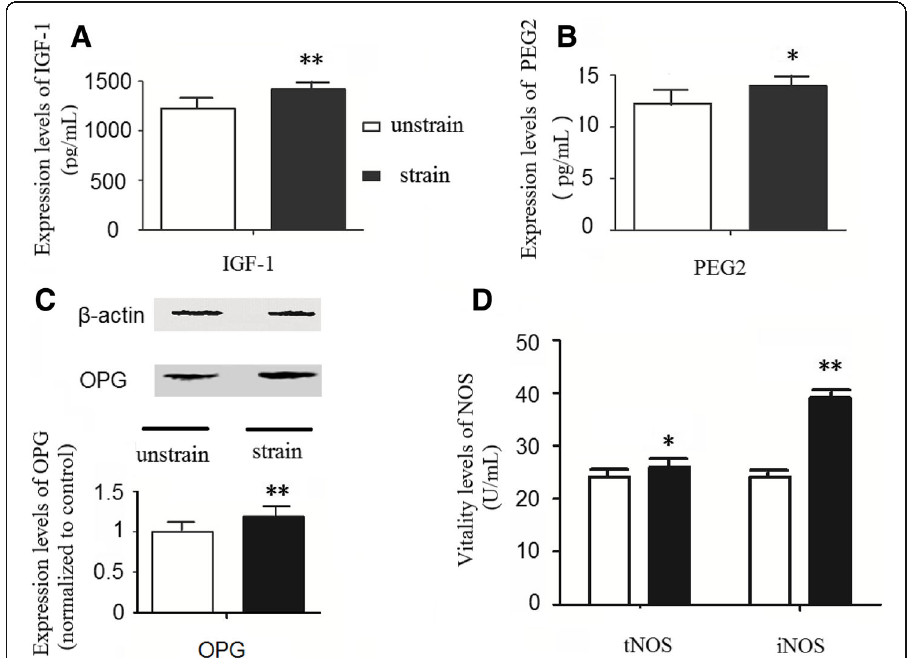
Fig. 1 MLO-Y4 cells responded to a mechanical tensile strain of 2500 microstrain ( με ) at 0.5 Hz for 8 h. a/b After MLO-Y4 cells were stimulated by the mechanical tensile strain, the contents of IGF-1 and PGE2 in the supernatant of cell culture medium were increased ( n = 5). c The mechanical tensile strain increased protein levels of OPG (osteoprotegerin) of MLO-Y4 cells ( n =6). d Following mechanical tensile strain, the activities of NOS in the cells were up-regulated ( n =5). * P <0.05 and ** P <0.01, compared with the unstrained control